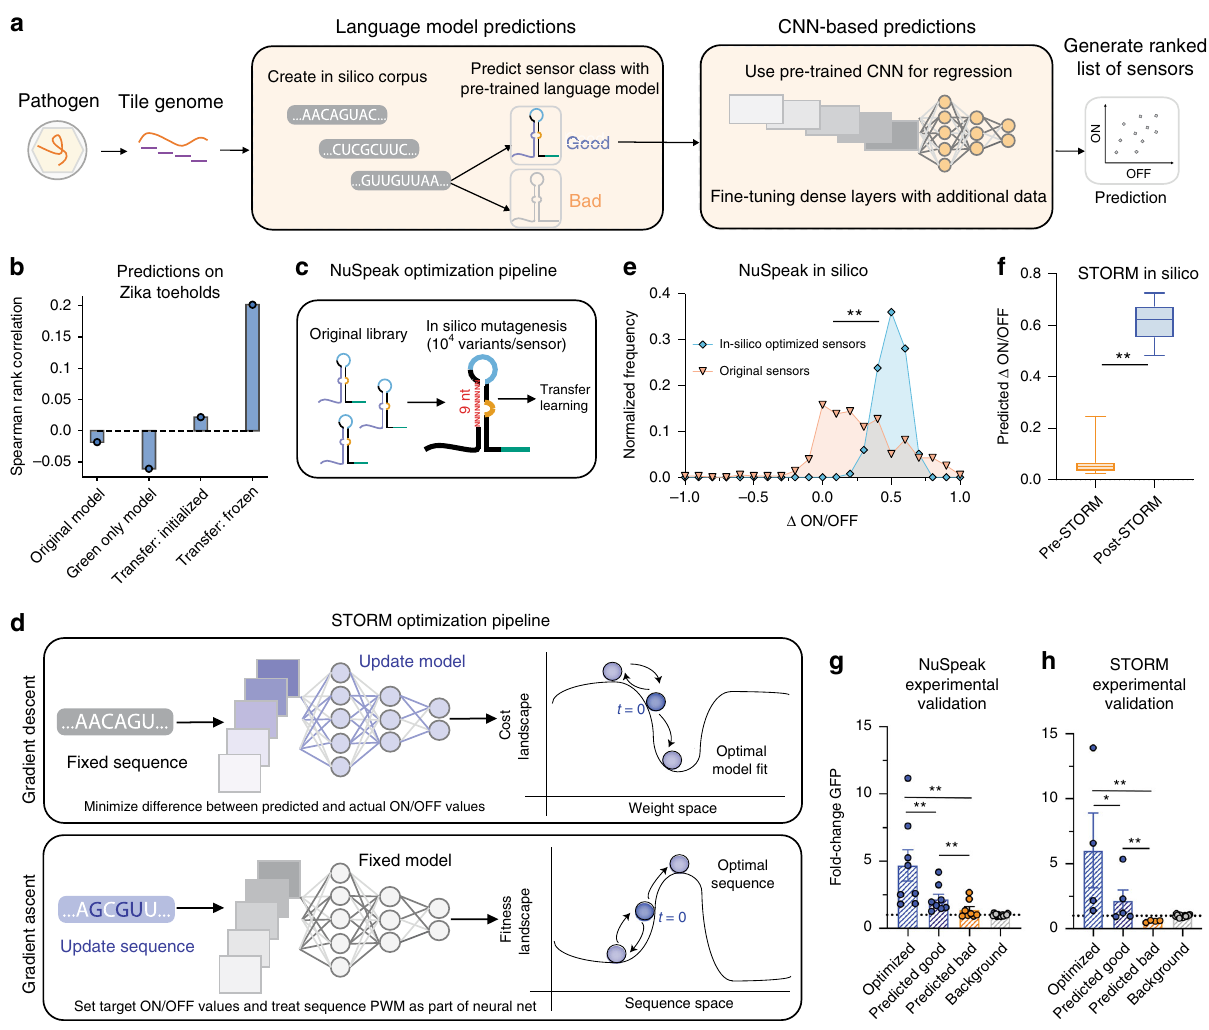
Fig. 4 Prediction and optimization of toeholds can be used for diagnostic sensor development. a Diagnostic sensor optimization pipeline involves tiling the genome of a pathogen, creation of an in silico corpus, and utilizing both the natural language processing (NLP)-based and convolutional neural network (CNN)-based models to generate a list of sensors for experimental validation. b To balance the utility of the large Angenent-Mari et al. 30 dataset with the nature of the Green et al. dataset 8 , which tested toeholds with free RNA as opposed to switch-trigger fusions, we used transfer learning to fi ne-tune the existing model and achieve a higher degree of correlation with the predictions on an external validation set of free-trigger Zika toeholds 10 ( N = 24). Data are shown for the CNN-based model rank predictions. c The NuSpeak optimization pipeline was designed to maintain base-pairing complementarity in the switch while producing all possible variants of positions 21 – 30. Sequences are then run through the consensus pipeline with fi ne-tuned models as above to produce a ranked list of sensors for a given region. d In contrast to traditional model training, which uses gradient descent to optimize the model ’ s weights from randomly initialized values (dark blue, time = 0) and predict the ON and OFF values for any given sequence, the CNN-based model can be inverted for gradient ascent of the sequence. Target ON and OFF values can be set, and the sequence space can be explored, starting at a given initialized sequence (dark blue, time = 0), to achieve those target values while the trained model remains fi xed. Both optimization pipelines effectively improve the in silico ON/OFF ratio. e NuSpeak was used to optimize sequences with an increase in in silico ON/OFF ratio (blue circle) from the original ON/OFF ratio (orange triangle) for experimentally tested sequences ( N = 354, p = 4.54 ×10 − 33 ). f Likewise, the Sequence-based Toehold Optimization and Redesign Model (STORM) was used to optimize experimental sequences, with center line indicating median and box limits indicating 25th and 75th quartile ( N = 20, p = 3.33 × 10 − 8 ). For ( e , f ), a two-tailed Mann-Whitney U test was used. g , h Both pipelines can be used to predict and optimize SARS-CoV-2 viral RNA sensors, with experimentally validated toeholds performing as predicted. There is a signi fi cant increase in NuSpeak predicted bad ( N = 8) and predicted good ( N = 8) values ( p = 0.026), as well as predicted good and optimized ( N = 8) values ( p = 0.020) and predicted bad and optimized values ( p = 0.004). Likewise, there is a signi fi cant increase in STORM predicted bad ( N = 4) and predicted good ( N = 5) values ( p = 0.010), as well as predicted good and optimized ( N = 4) values ( p = 0.089) and predicted bad and optimized values ( p = 0.015). For ( g , h ), error bars indicate mean ± S.E.M and a